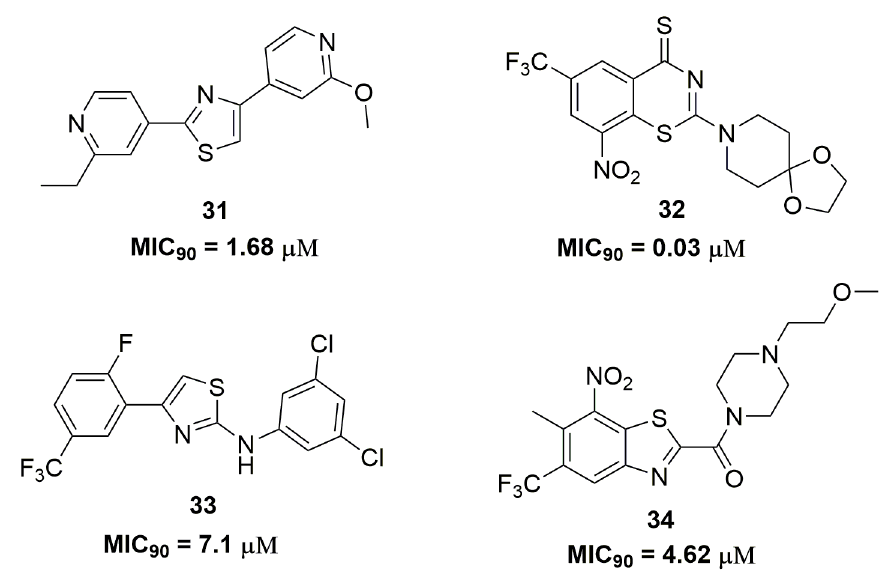
Figure 11. Sulfur-containing heterocycles with potent antitubercular activity.